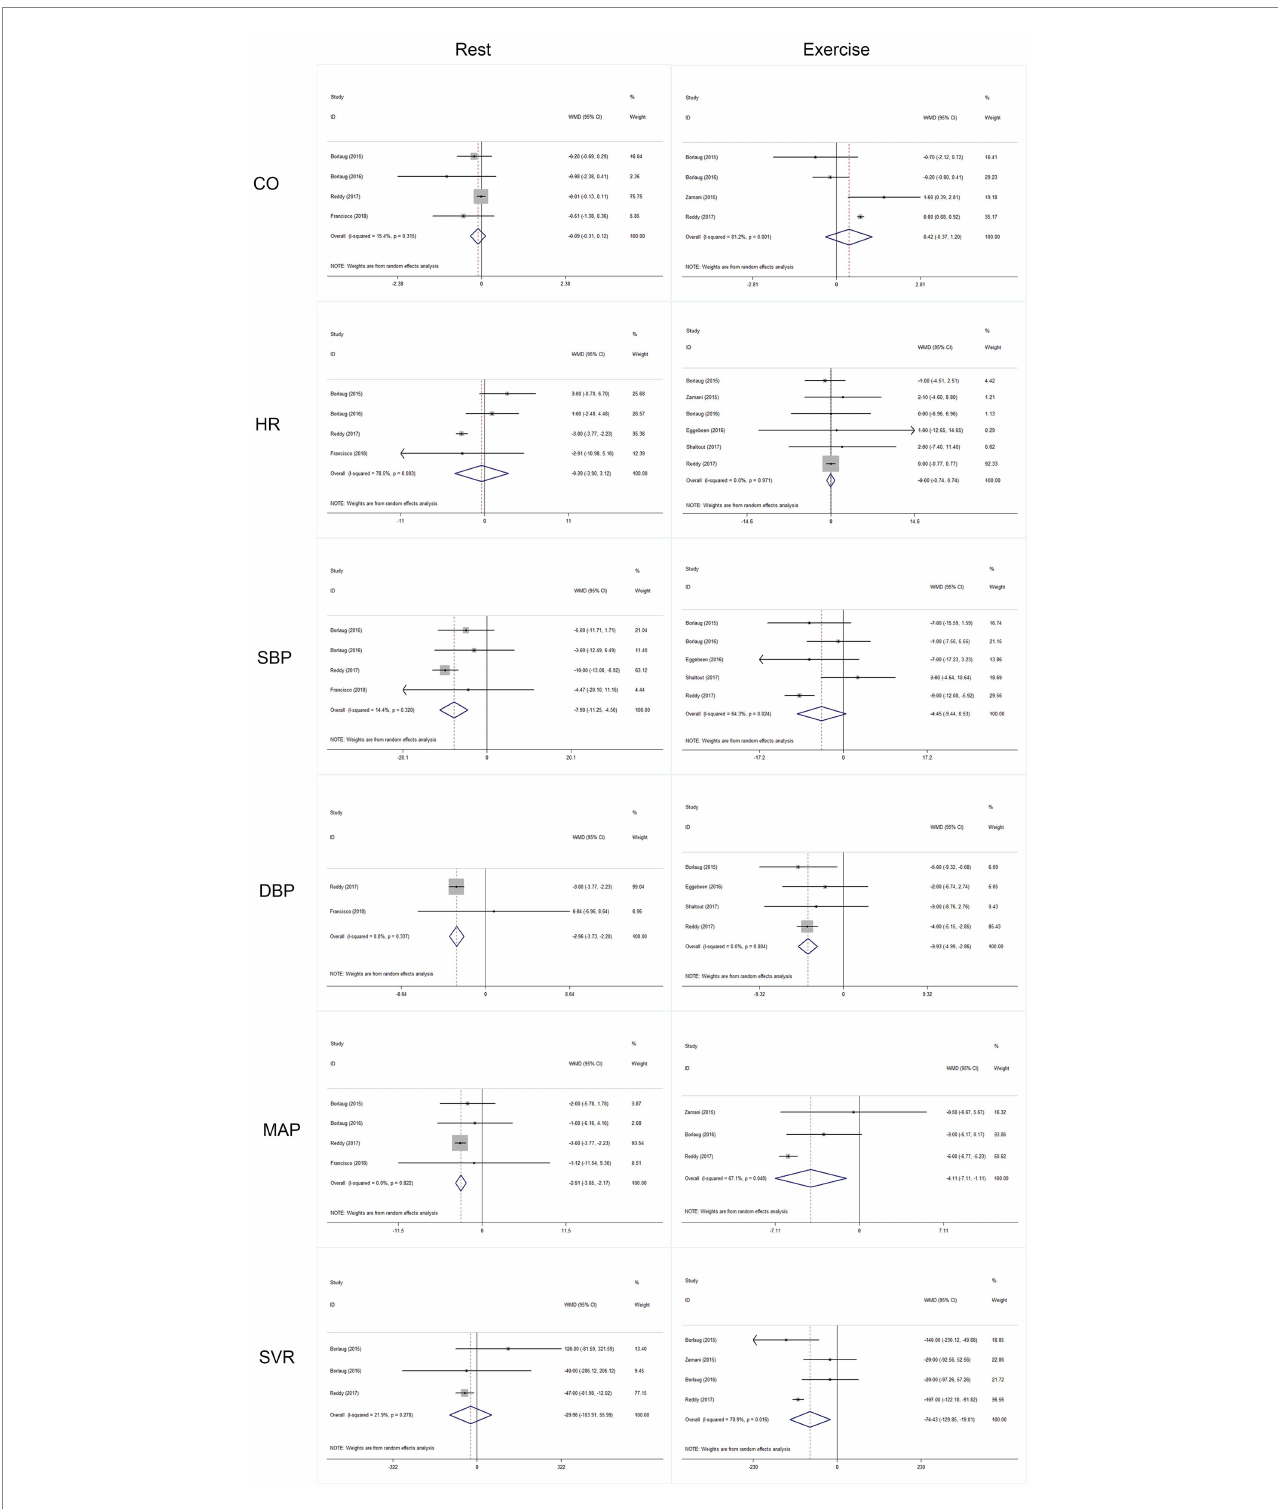
FIGURE 4 Statistical syntheses of secondary